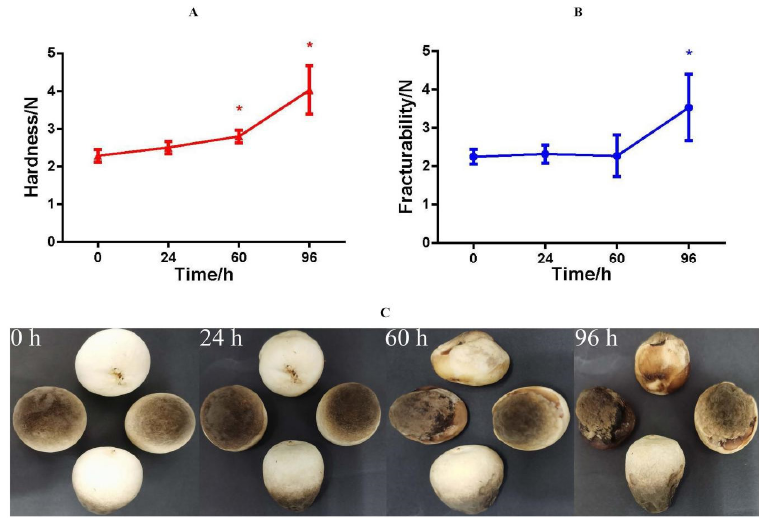
Figure 1. Changes in the hardness ( A ), fracturability ( B ), and phenotype ( C ) of V. volvacea fruiting bodies during different storage periods. Each bar represents the mean ± SE of the individual samples, and * represents p < 0.05.